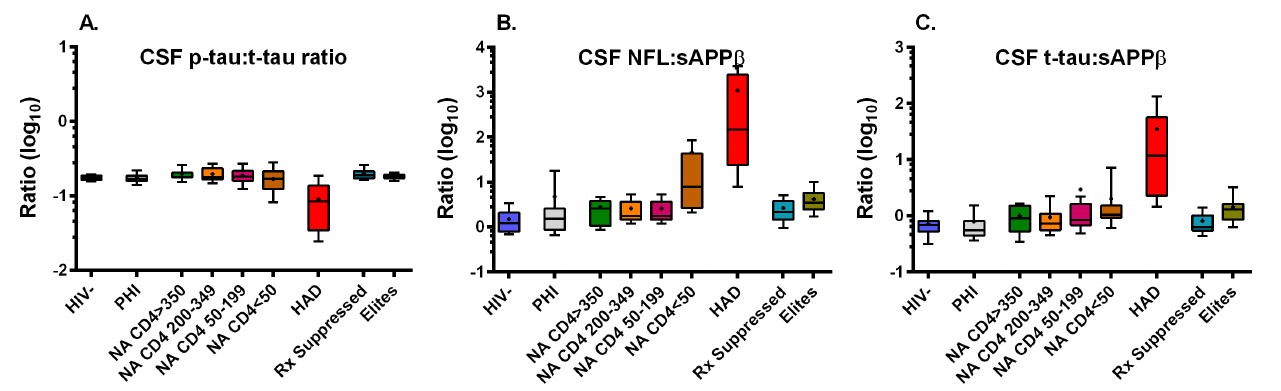
Fig. 2. Ratios of selected neuronal biomarkers. The plots are similar in format to those of Fig. 1, but plot ratios (log 10 differences) of selected neuronal biomarkers on log 10 scales that differ in relation to the magnitude and ranges of the differences. A. Ratio of CSF p-tau to t-tau in the nine groups. Only the HAD group differed from any of the others in Dunn’s multiple comparison test: compared to Rx suppressed and CD4 . 350 (p , 0.0001); to CD4 200–349 (p , 0.01); and to CD4 50–199 (p , 0.05). B. Ratio of CSF NFL to CSF sAPP b . HAD group differed from HIV- and PHI (p , 0.0001), from Rx suppressed, CD4 + . 350, CD4 + 200–349, CD4 + 50–199 (p , 0.001); CD4 , 50 differed from HIV- (p , 0.001) and from CD4 + . 350 (p , 0.05). C. Ratio of CSF t-tau to sAPP b . The HAD group differed from HIV-, Rx suppressed and PHI (p , 0.0001), from CD4 200–349 (p , 0.001), from CD4 . 350 (p , 0.01), from CD4 50–199 and from PHI (p , 0.05); CD4 , 50 differed from PHI (p ,